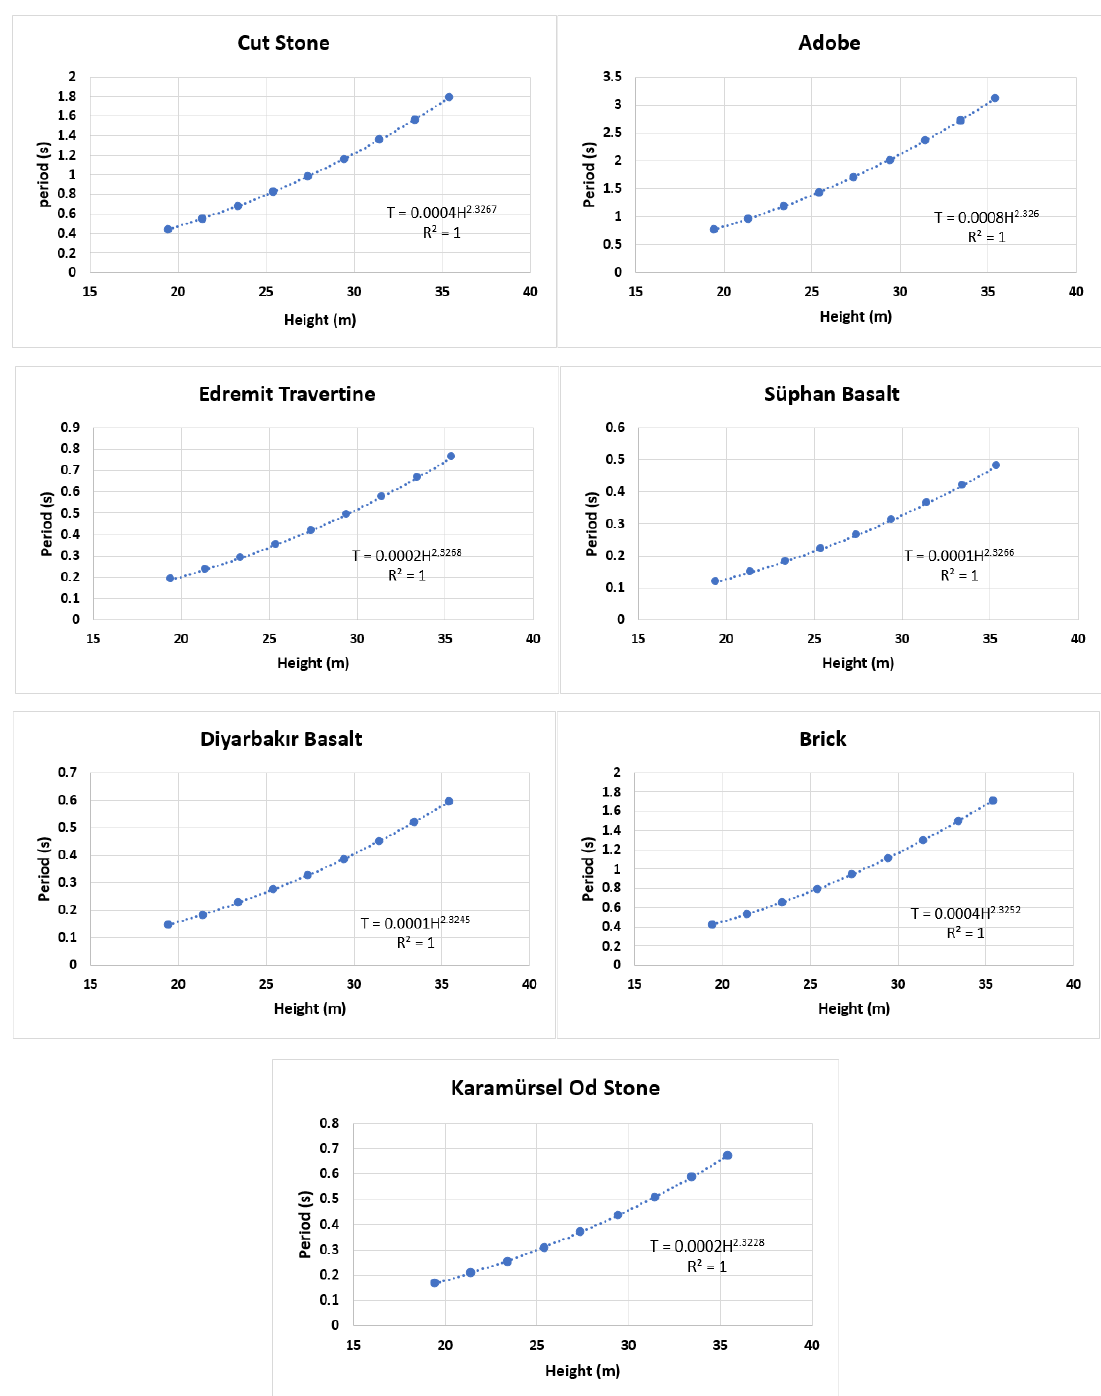
Figure 9. Obtaining the natural vibration period of the different materials considered in the study depending on the height. depending on the